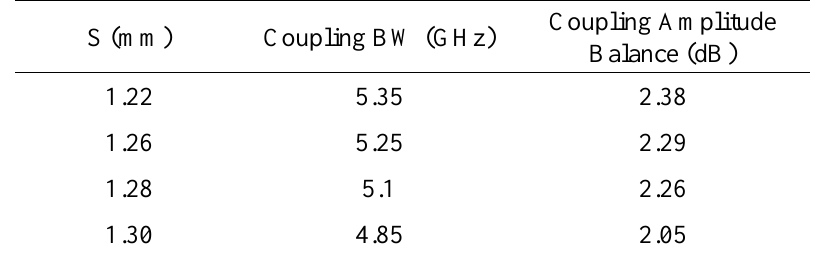
Table 1. Coupler performances vs. width of a gap (S)